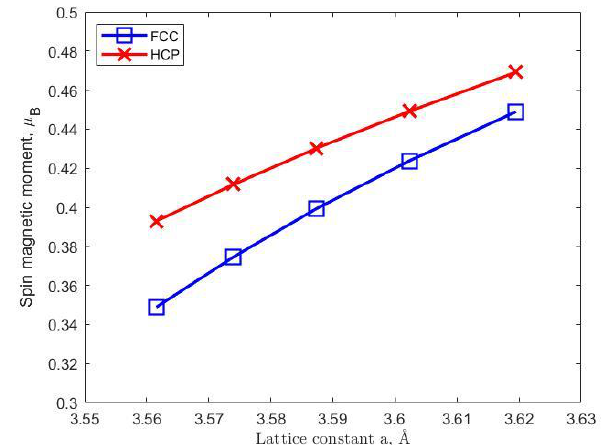
Figure 8. Paramagnetic spin moment on a nickel atom as a function of equilibrium face-centered-cubic (FCC) lattice parameter at the corresponding temperature (see Figure 4). Solid lines with blue triangles and red squares show the results for, respectively, FCC and hexagonal-close-packed (HCP) crystal structures.